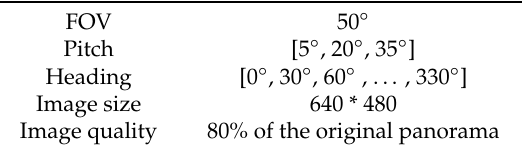
Table 2. The street view dataset information.